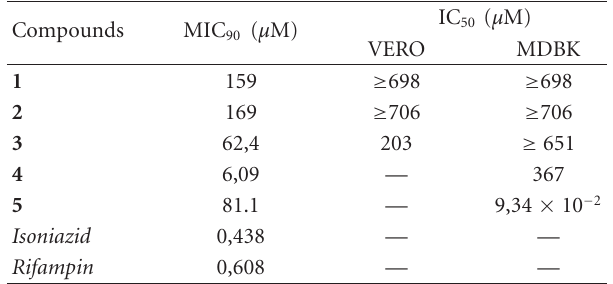
Table 2: Mass spectrometry data of MEMEs from M. tuberculosis